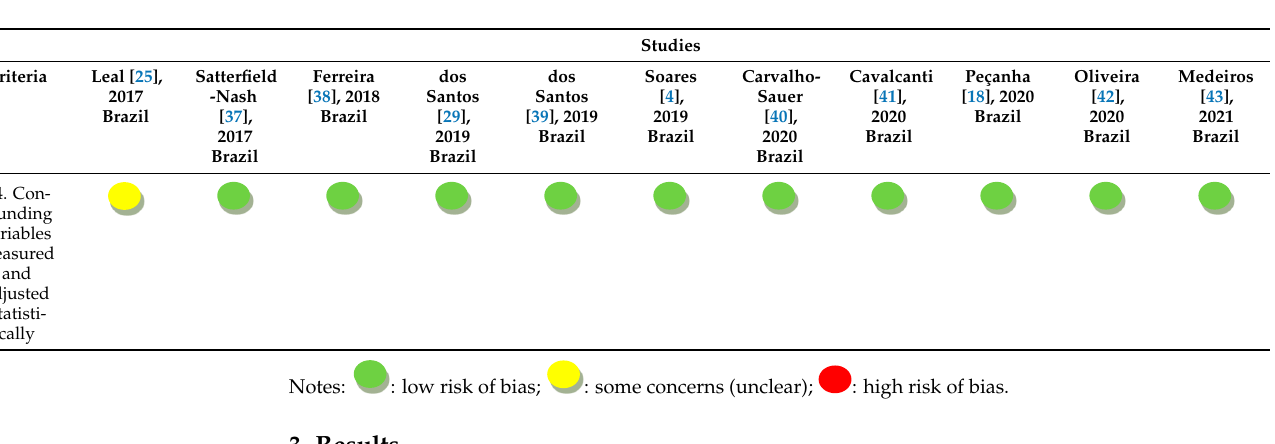
Table 1. Methodological quality and risk of bias of included articles.